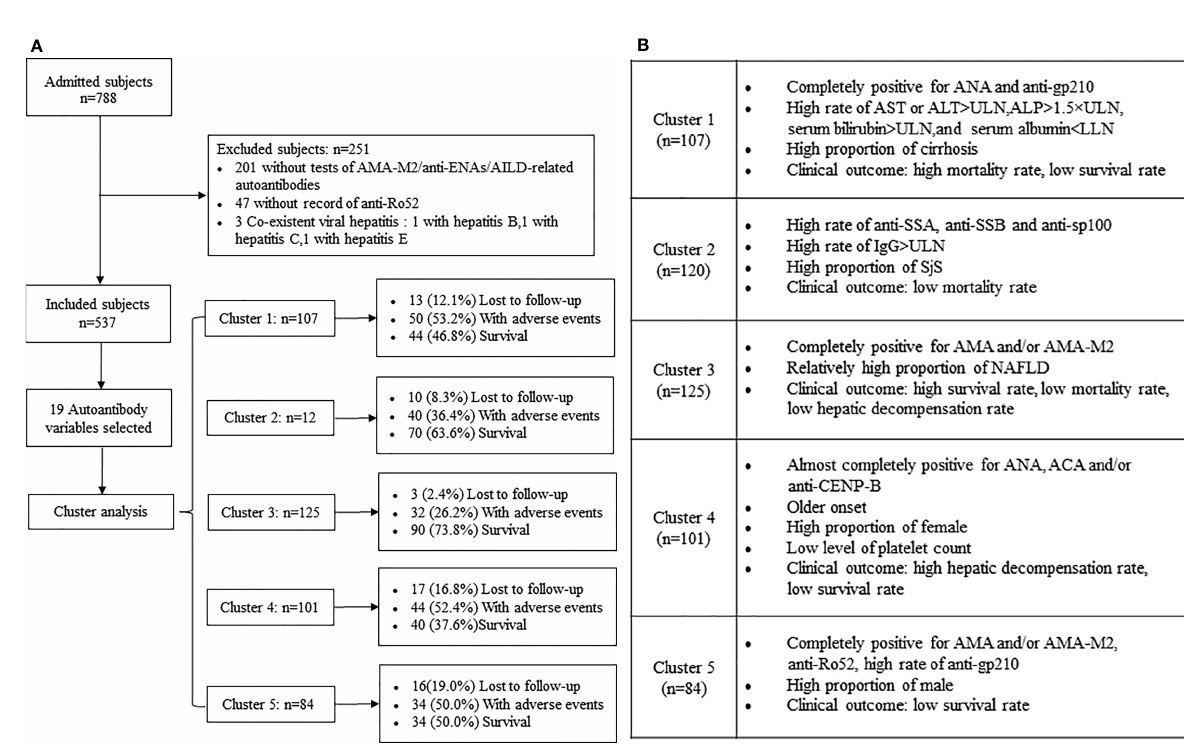
FIGURE 1 (A) Flowchart for selection of patients with PBC and follow-up of the study cohort strati fi ed by autoantibody clusters. (B) Main characteristics of the fi ve clusters (clusters 1-5) of patients with